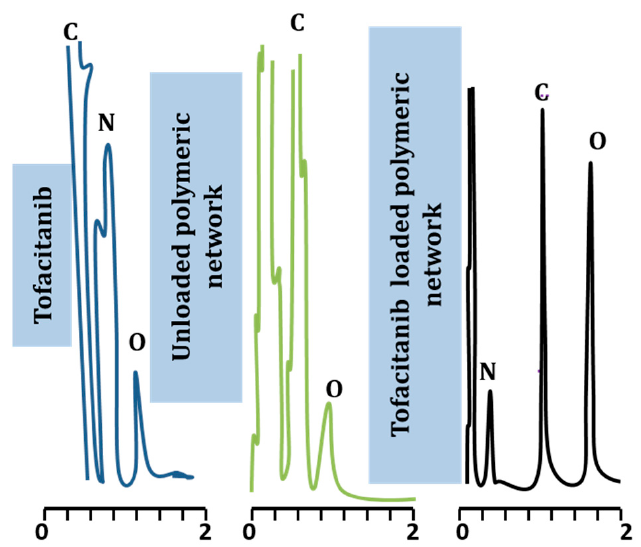
Figure 2. EDX spectra of Tofacitinib, unloaded microparticles, tofacitinib-loaded network, where C, N, and O represent carbon, nitrogen, and oxygen,